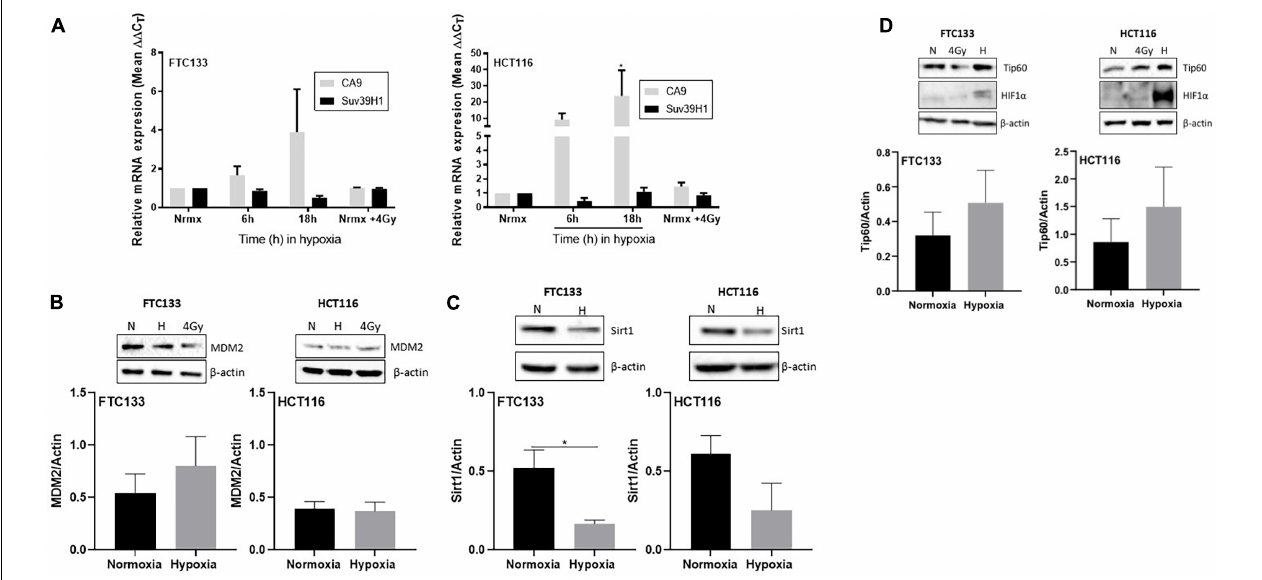
FIGURE 3 | Suv39H1 is regulated at the protein level in hypoxia in a manner independent of MDM2 or Sirt1 protein expression levels. Cells were exposed for 6 or 18 h to normoxia (21% O 2 ) or hypoxia (0.1% O 2 ). After that time RNA was extracted and analyzed by RT-PCR. The graph represents the relative gene expression of Suv39H1 and CA9 compared to the normoxic control. CA9 is used as a control for hypoxia. Bars represent the mean ± SEM of four independent experiments (A) . Cells were incubated in normoxia (N; 21% O 2 ) or severe hypoxia (H; 0.1% O 2 ) for 18 h prior to lysis and Western blotting. HIF-1 α was used as a control for hypoxic conditions and β -actin as a loading control. A representative image of one membrane is shown for MDM2 (B) , Sirt1 (C) and Tip60 (D) . The graphs represent the densitometry of protein levels normalized by the loading control. Three independent experiments were performed and the bar represents the mean ± SEM. * p ≤